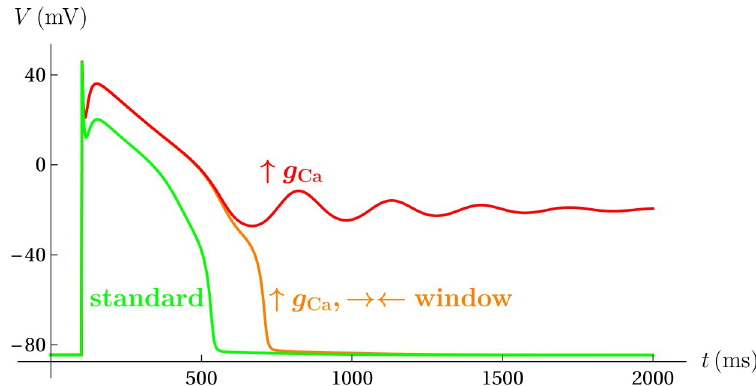
Fig 11. Symmetric narrowing of the model window region abolishes I Ca-L amplitude-induced repolarization failure. Repolarization failure is promoted by increasing the conductance of the I Ca-L current (red). Narrowing the window recovers the action potential response (orange). Green: ( g Ca , Δ V 1/2 ( d 1 ), Δ V 1/2 ( f 1 )) = (0.112, 0, 0); orange: ( g Ca , Δ V 1/2 ( d 1 ), Δ V 1/2 ( f 1 )) = (0.18, 0, 0); red: ( g Ca , Δ V 1/2 ( d 1 ), Δ V 1/2 ( f 1 )) = (0.18, 1, -1).